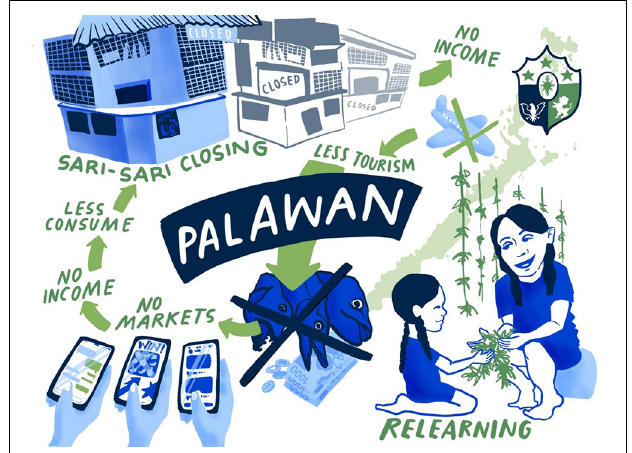
FIGURE 1 | COVID-19 scenario for Palawan. Illustration by Lina Ernst